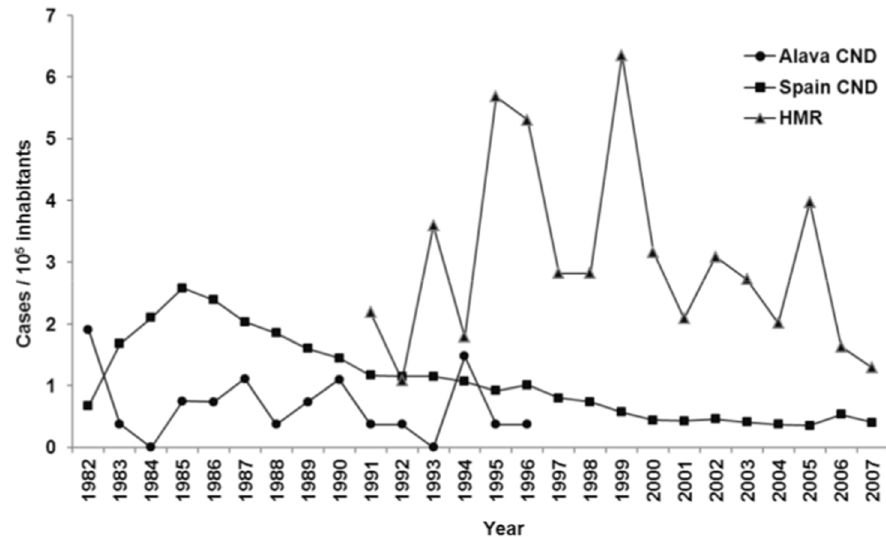
Figure 1. Annual incidence rate per 100,000 inhabitants of cystic echinococcosis in the province of A´ lava using hospital medical records (1991–2007), and the national surveillance system at the provincial (1982–1996) and national (1982–2007) levels. Legend: Full circles: Estimated annual incidence rate using the A´lava Compulsory Notifiable Diseases system; Full squares: Estimated annual incidence rate using the National (Spain) Compulsory Notifiable Diseases system including data from all 17 Spanish autonomous regions (1982–1996) and the nine Spanish autonomous regions considered endemic after (1997–2007); Full triangles: Estimated annual incidence rate using the Hospital Medical Records from the two treating hospitals for CE in A´lava. CND: Compulsory Notifiable Diseases system; HMR: Hospital Medical